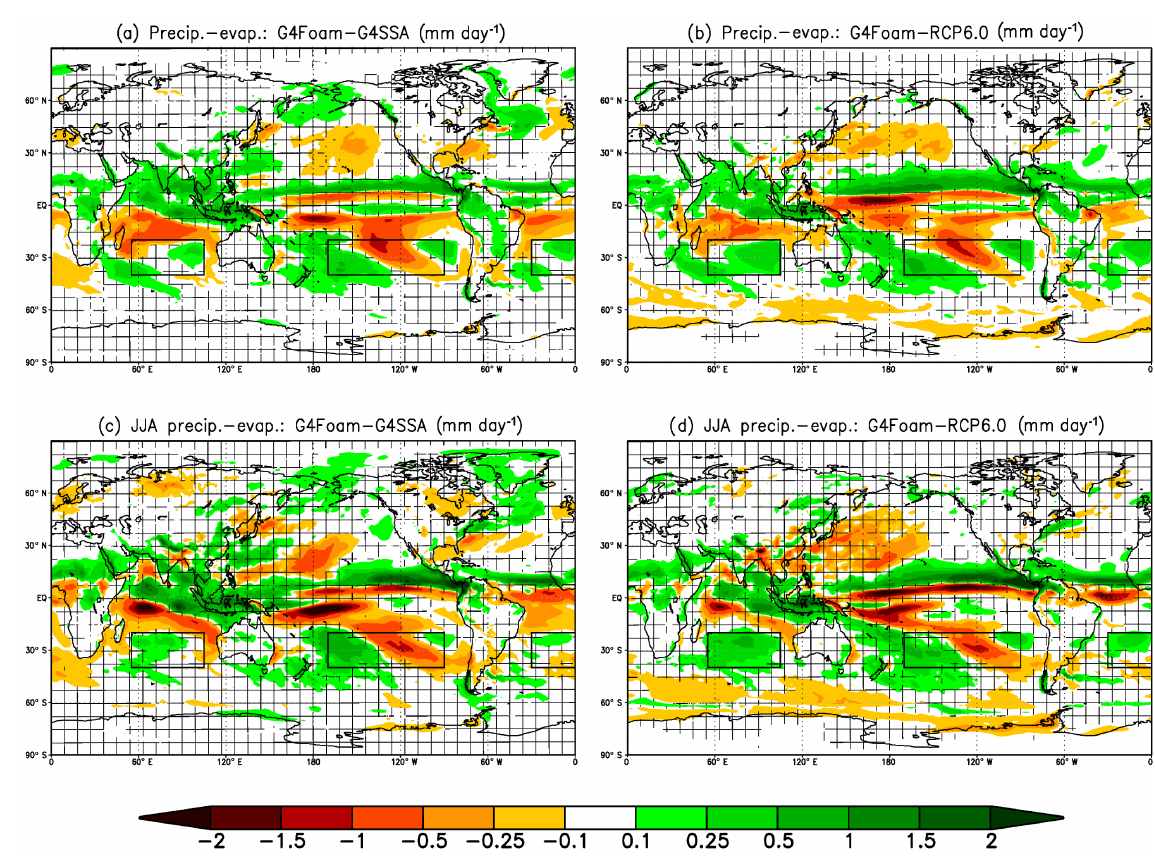
Figure 8. 2030–2069 precipitation minus evaporation difference (mmday − 1 ) between G4Foam and (a) G4SSA, (b) RCP6.0, (c) G4SSA during JJA, and (d) RCP6.0 during JJA. Hatched regions are areas with p >0.05 (where changes are not statistically significant based on a paired t test). Black boxes enclose foamed